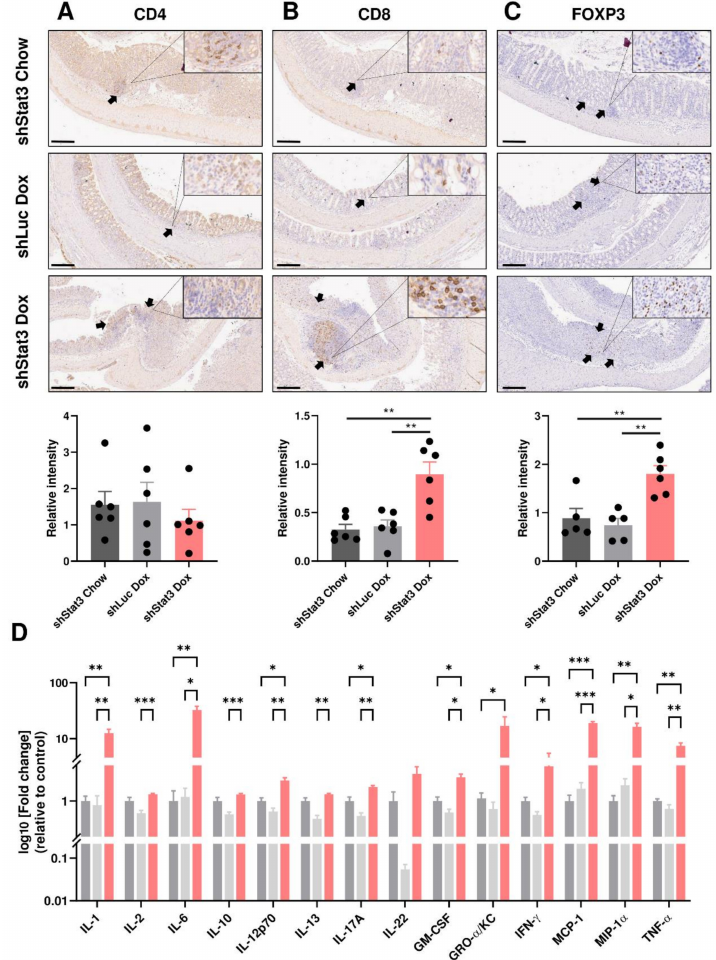
Figure 4. Stat3 knockdown increases immune cell infiltration and elevates production of cytokines and chemokines in colonic tissue. Immunohistochemistry assessment of: ( A ) CD4; ( B ) CD8; and ( C ) FOXP3 of colons harvested from shStat3 Chow, shStat3 Dox, and shLuc at the experimental endpoint ( n = 5–6 per experimental group). Scale bar: 200 µ m; ( D ) Cytokine and chemokine levels from colonic tissues harvested from shStat3 Chow, shStat3 Dox, and shLuc at the experimental endpoint as analysed by multiplex cytokine array. The relative fold change of each cytokine in dox-treated shStat3 and shLuc group was compared to that of the shStat3 Chow control. Data represent mean ± SEM. Data were checked for normal distribution with Kolmogorov–Smirnov test and statistical analysis was performed using one-way ANOVA with Tukey’s multiple comparisons test. * p < 0.05; ** p < 0.01; *** p < 0.001; **** p <